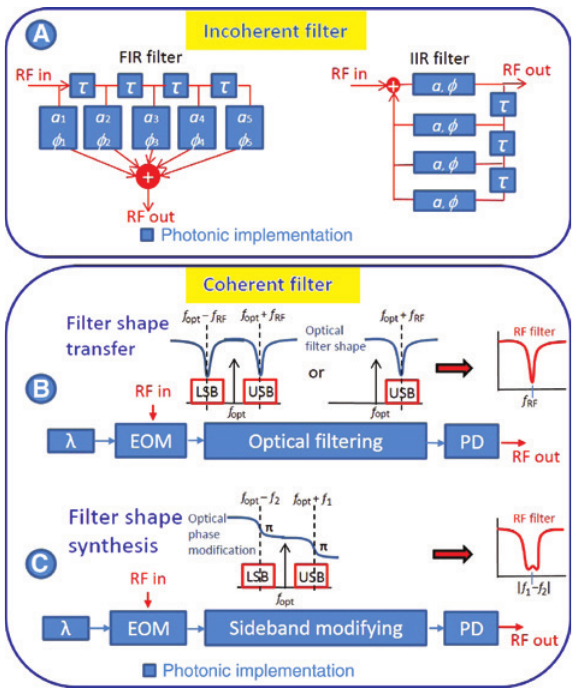
Figure 2: Typical approaches for implementing MWP filters. (A) Incoherent filter, (B) coherent filter by means of filter shape transfer, and (C) coherent filter by means of filter shape